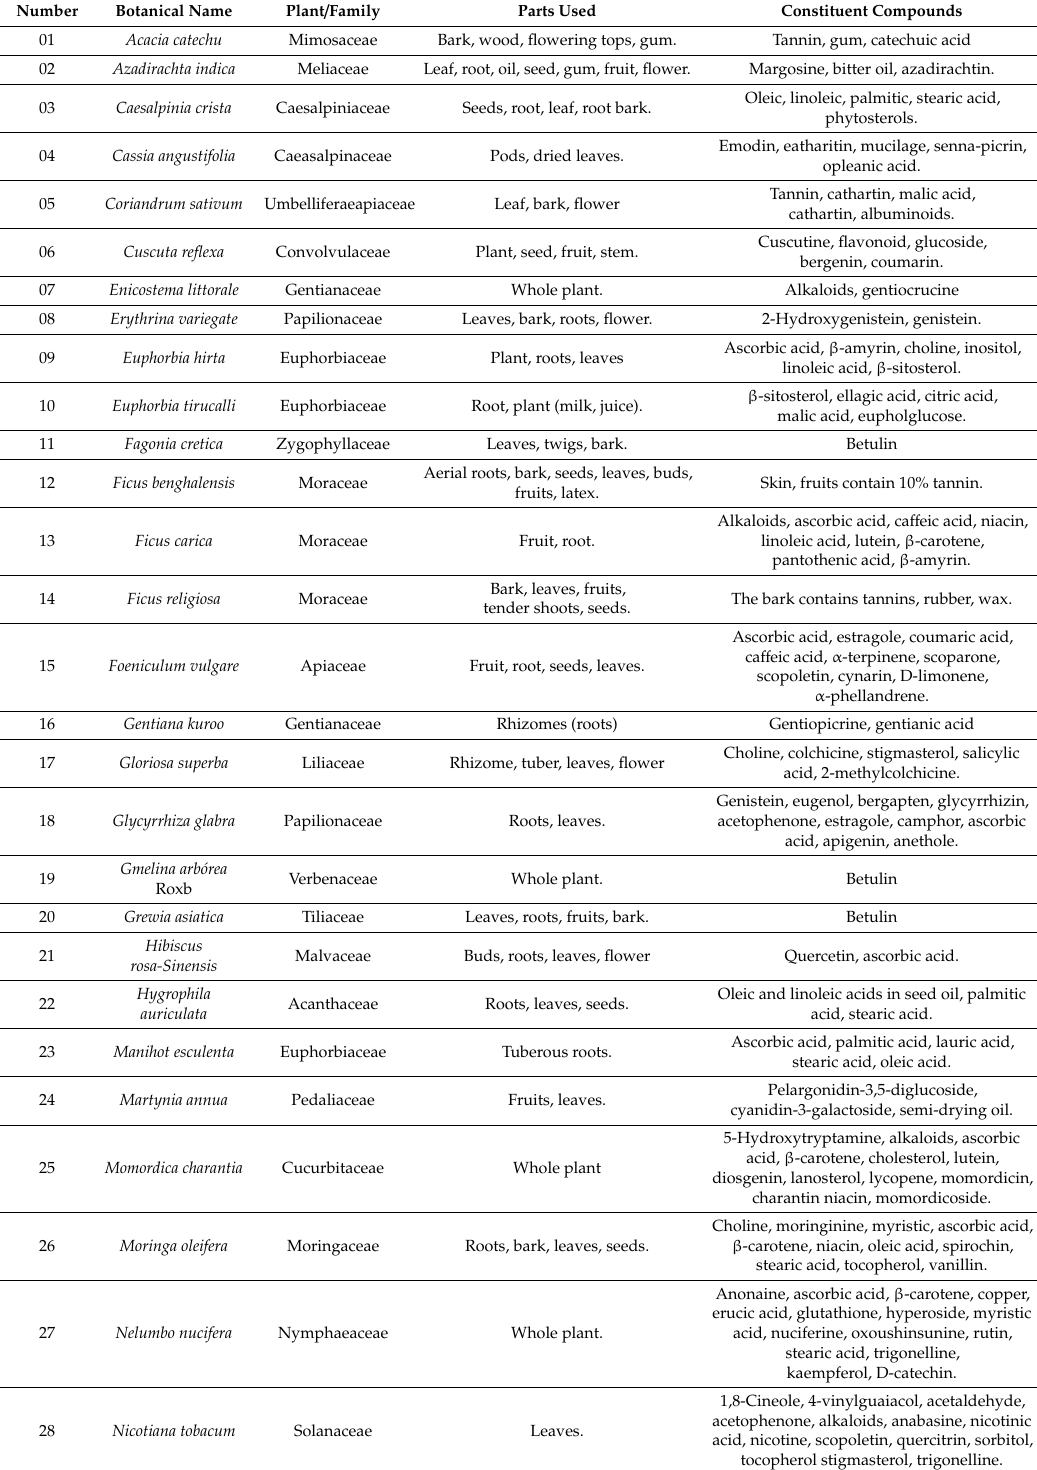
Table 2. Anti-inflammatory activity of some medicinal